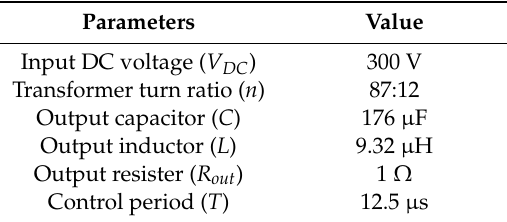
Table 2. Simulation parameters.